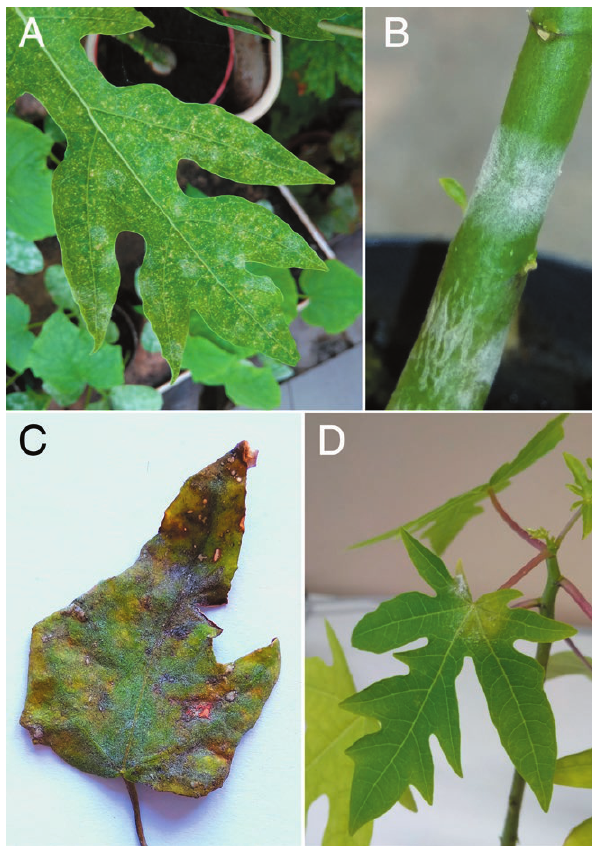
Figure 1. Powdery mildew symptoms on papaya plants. Symptoms caused by: A) Podosphaera xanthii , B) Erysiphe sp., C) Erysiphe cru- ciferarum and D) Erysiphe